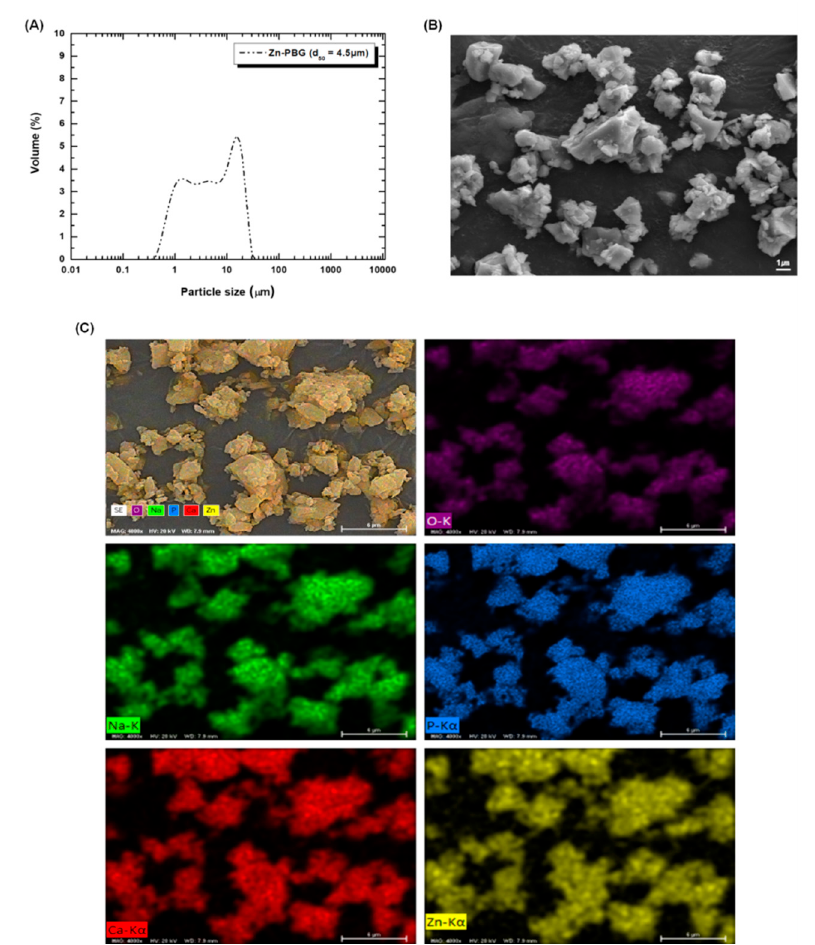
Figure 2. Particle size distributions ( A ), FE-SEM images of Zn-PBG powder (before mixing with flowable composite resin) ( B ) and overlap of the EDX mapping of the chemical elements distribution ( C ). Scale bar is 1 μ m ( B ) and 6 μ m ( C ).